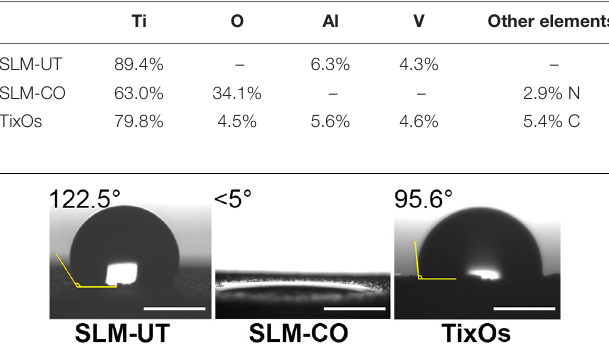
TABLE 3 | The surface chemical composition (weight percentage) of three implants in this study.